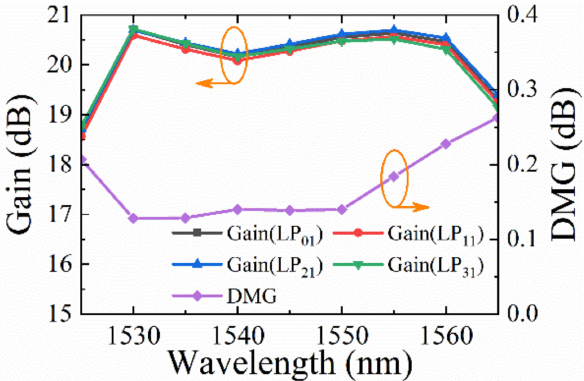
Figure 4. Gains and DMG versus signal